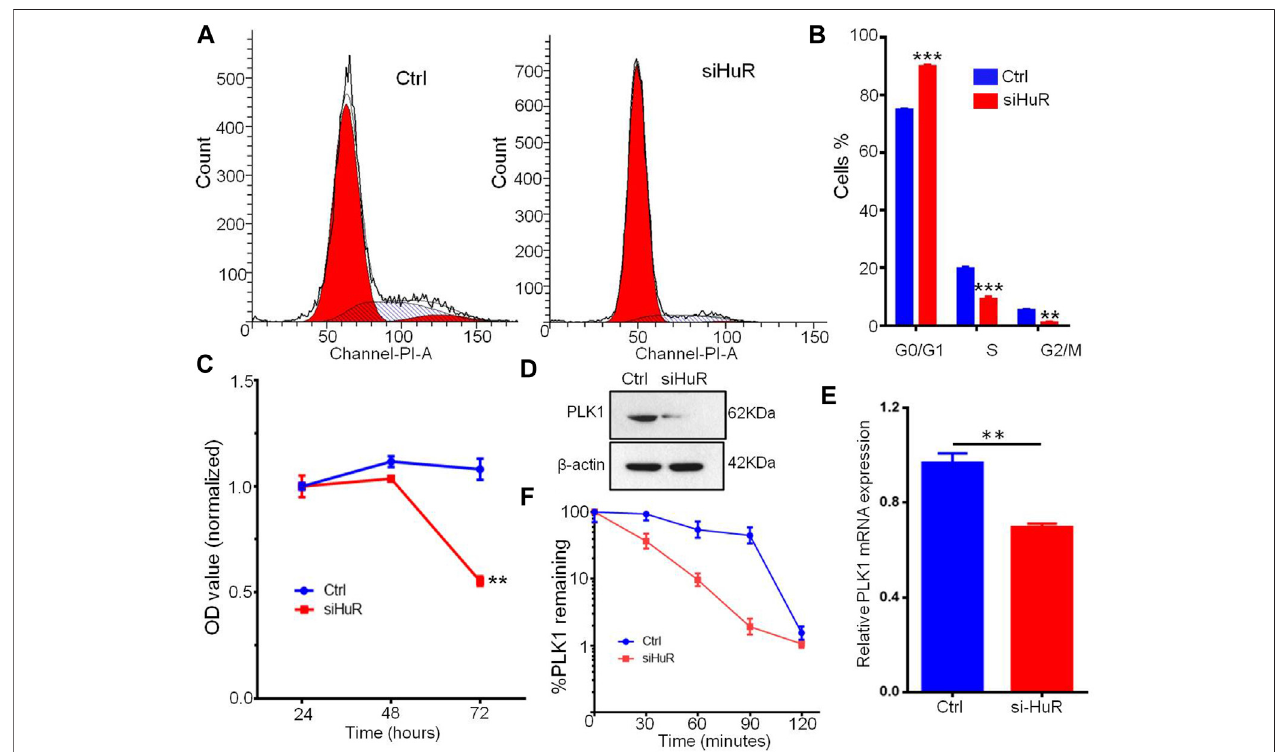
FIGURE 6 | HuR promotes the cell cycle progression and proliferation of A549 cells. (A,B) Cell cycle histograms of A549 HuR KD cells compared with A549 cells. (C) .CCK-8assayoftheproliferationofA549cellsandHuRKDA549cells. (D) .PLK1wasmeasuredbywesternblotting,andtonormalizeproteinloading,theblotswere also probed for β -actin. (E) . Relative PLK1 mRNA expression in A549 cells with HuR KD for 24 h (F) . The decay rates of the PLK1 and GAPDH mRNA were assessed in A549cellsbyRT-qPCRatdifferenttimepoints(30,60,90,120 min)aftertranscriptioninhibitionwithactinomycinD.Dataarerepresentedasthemean±SEM.* p < 0.05, ** p < 0.01, *** p < 0.001. n =